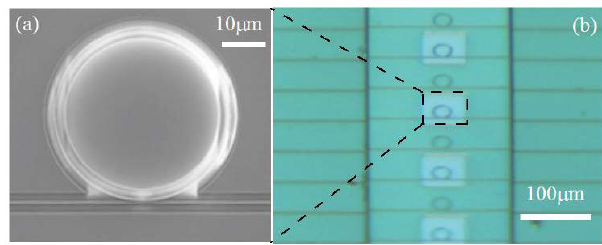
Figure 7: (a) Picture of a fabricated SOI ring resonator. (b) Image of a finished sample with a microfluidic channel attached.